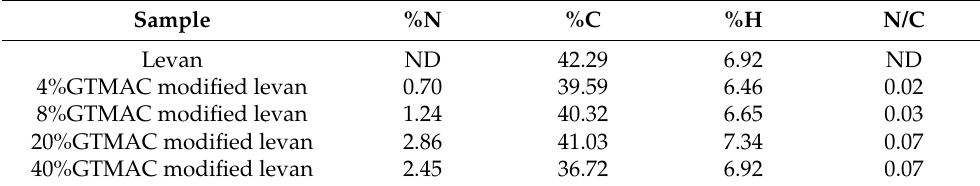
Table 1. CHN analysis of QA-levan obtained from different condition.